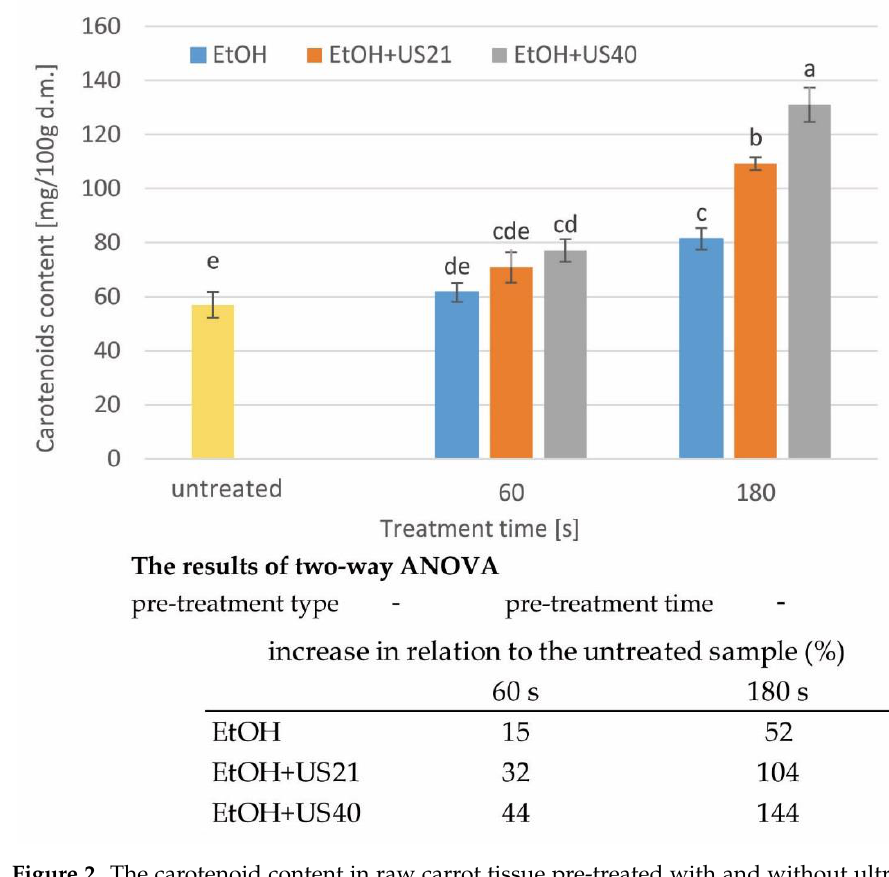
Figure 2. The carotenoid content in raw carrot tissue pre-treated with and without ultrasound; a, b, etc.—different letters indicate different homogeneous groups (α = 0.05), the results of two-way ANOVA indicate the significance (*) or insignificance (-) of the influence of the type and time of treatment (α = 0.05). In table—the increase in carotenoid content in relation to the untreated sample.